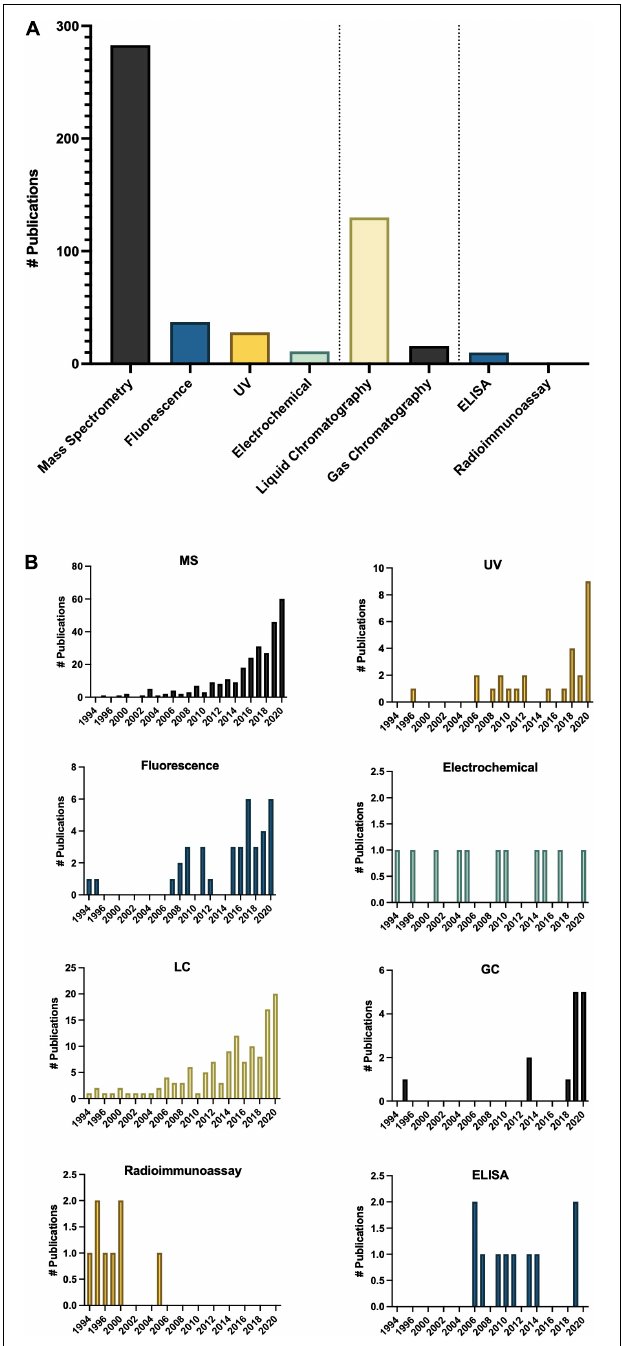
FIGURE 6 | Methods of analysis of melatonin in plants (A) total number of publications by technique over the time period queried and (B) Number of publications by technique by year. ELISA, enzyme-linked immunosorbent assay; GC, gas chromatography; LC, liquid chromatography; MS, mass spectrometry; UV, ultra violet detection.